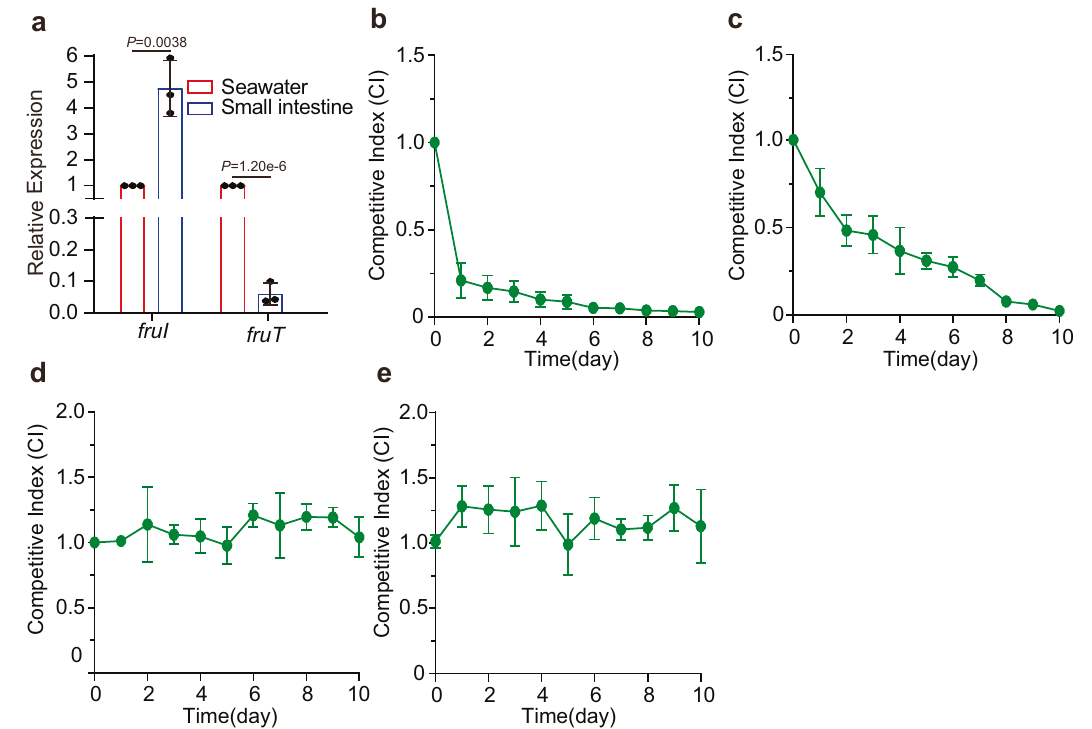
Fig. 6 V. cholerae turns on FruT in response to O 2 for growth in seawater. a qRT-PCR expression level of fruI and fruT in the mouse small intestine and seawater under aerobic conditions. Data represent the mean ± SD ( n = 3). b Competition assay comparing the survival ability of WT and Δ fruT within a membrane-enclosed environment in seawater that was replaced by fresh seawater every 6 h under aerobic conditions. c , d Competition assay comparing the survival ability of WT and Δ fruT located within a membrane-enclosed environment in arti fi cial seawater medium that was supplemented with 0.1 μ M fructose ( c ) or 0.1 μ M glucose ( d ) as the only carbon source every 6 h under aerobic conditions. e Competition assay comparing the survival ability of WT and Δ fruT located within a membrane-enclosed environment in arti fi cial seawater medium that was supplemented with 0.1 μ M fructose under anaerobic conditions. CI was determined as the output ratio of Δ fruT to WT lacZ- cells divided by the input ratio of Δ fruT to WT lacZ- cells. Data represent the mean ± SD ( n = 3). Signi fi cance is determined by two-tailed unpaired Student ’ s t test ( a ) and indicated as the P value; n.s. means no signi fi cant difference. Source data are included in Source Data fi